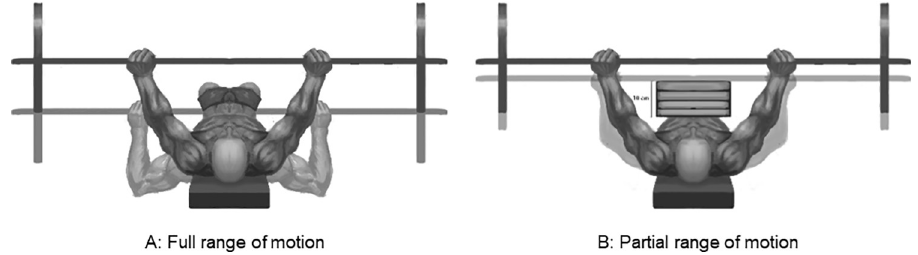
Fig 1. Bench press execution conditions. Partial ROM limited by four 2,5 cm thick